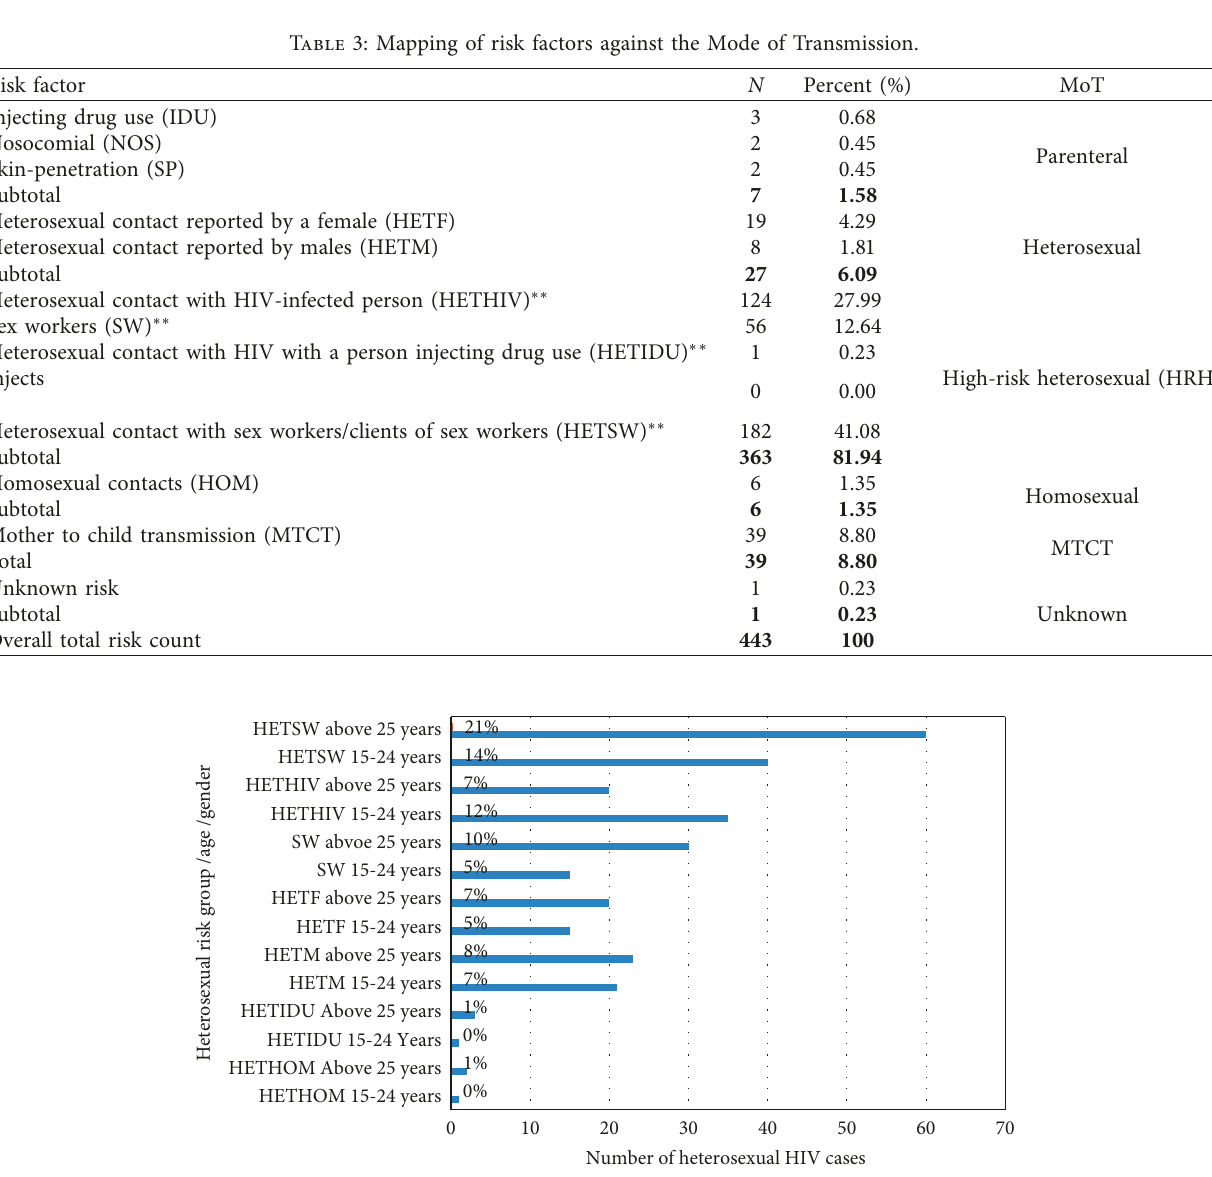
Figure 1: Distribution of heterosexual mode of transmission by age, gender, and risk group among the diagnosed HIV cases from 1993 to 2020, Bhutan.